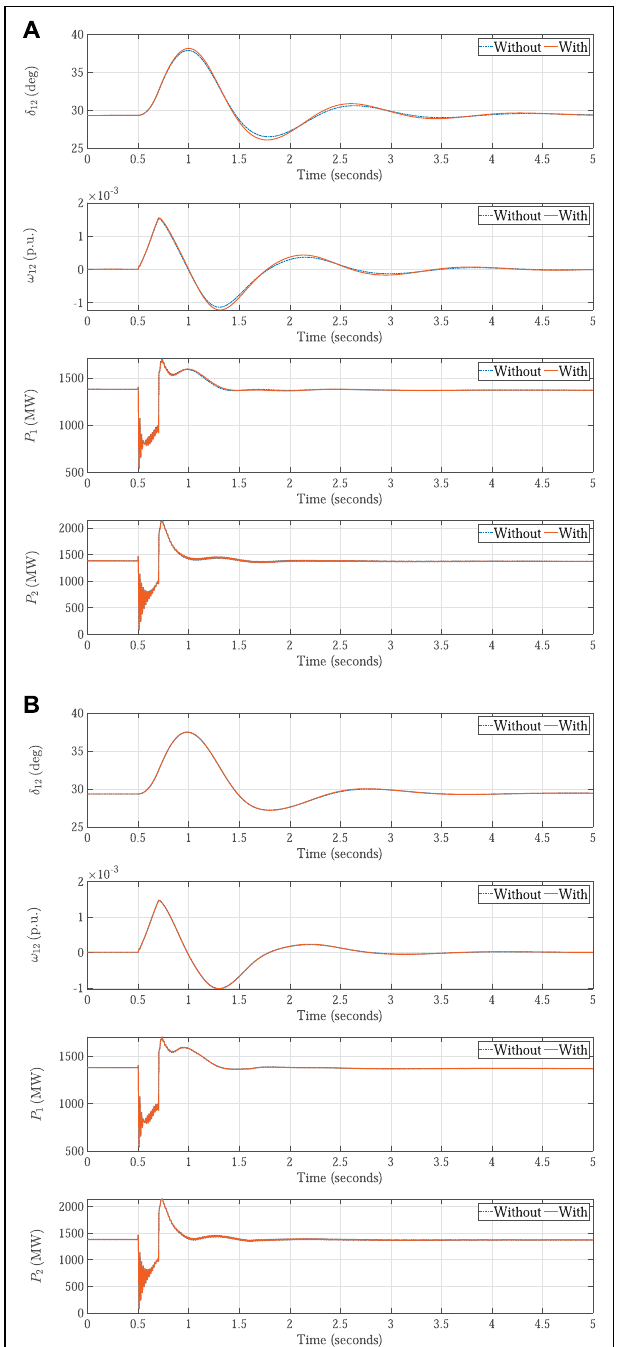
FIGURE 6 | Simulation results of the (A) SMC and (B) RNDC obtained under parameter variations.